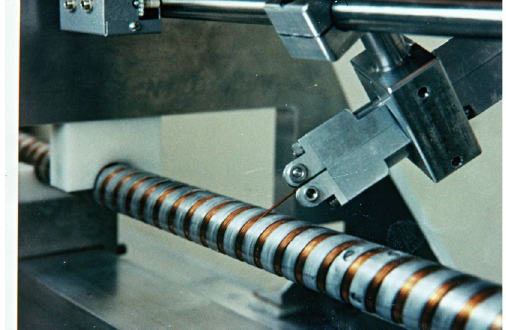
FIG. 3. Photograph of the five meter precision lathe developed to wind the superconducting helical magnet used in the first FEL amplifier and oscillator